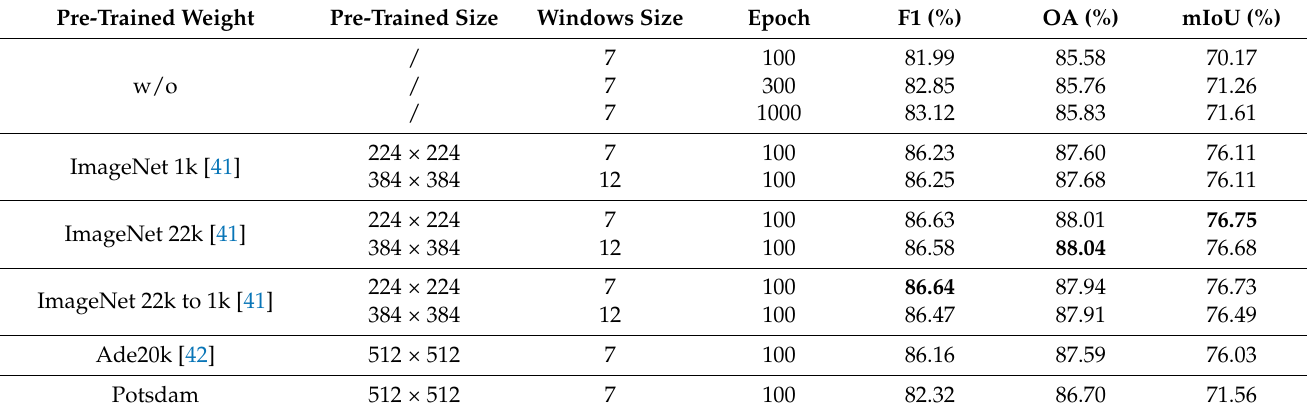
Table 2. Study for the pre-trained weights on Vaihingen dataset.